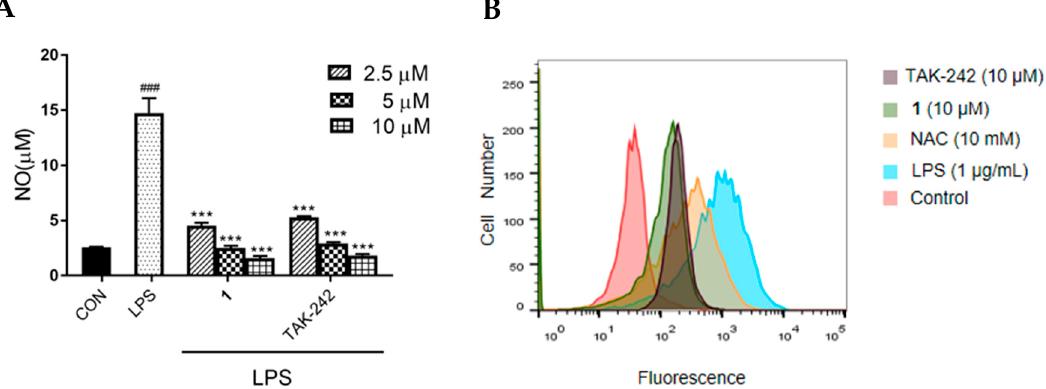
Figure 5. E ff ect of 1 on NO and ROS production in LPS-induced RAW 264.7 macrophages. ( A ) NO and ( B ) ROS was measured using the Griess systems and flow cytometry, respectively. For NO measurement, cells were incubated with varied concentrations of 1 (2.5, 5 or 10 µ M) or TAK-242 (2.5, 5 or 10 µ M) and treated with LPS (1 µ g / mL) for 24 h. For ROS determination, cells were incubated with 1 (10 µ M), TAK-242 (10 µ M) or NAC (10 mM) and treated with LPS (1 µ g / mL) for 24 h. Results are representative of three independent experiments. ### p < 0.005 vs. control cells, *** p < 0.005 vs. LPS-induced cells.